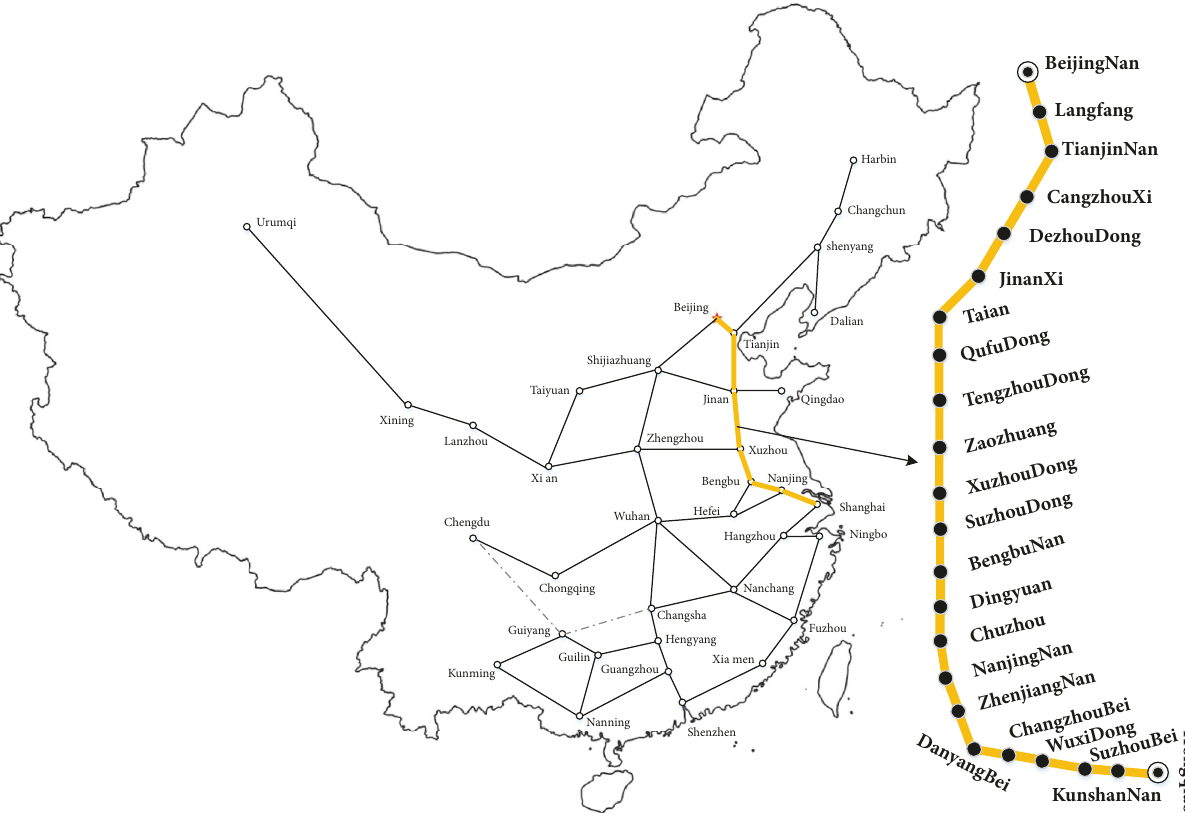
Figure 6: The overview of the Chinese high-speed railway network.